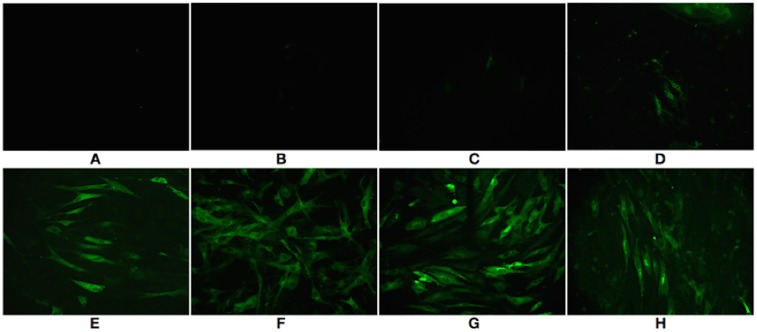
REV infection in chicken embryo fibroblasts.Detection of REV group antigen in infected monolayer of CEFs was visualised by IFA on day 1 (A), day 2 (B), day 3 (C), day 4 (D), day 5 (E), day 6 (F), day 7 (G) and day 10 (H) using fluorescence microscopy at an original magnification of 400×.